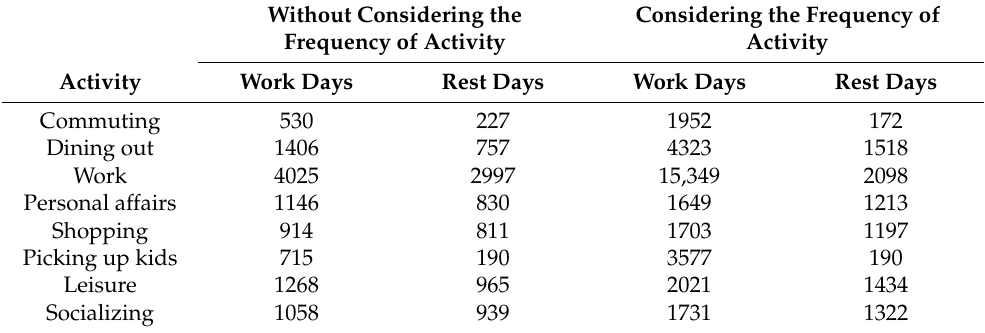
Table A1. Exposure level of each